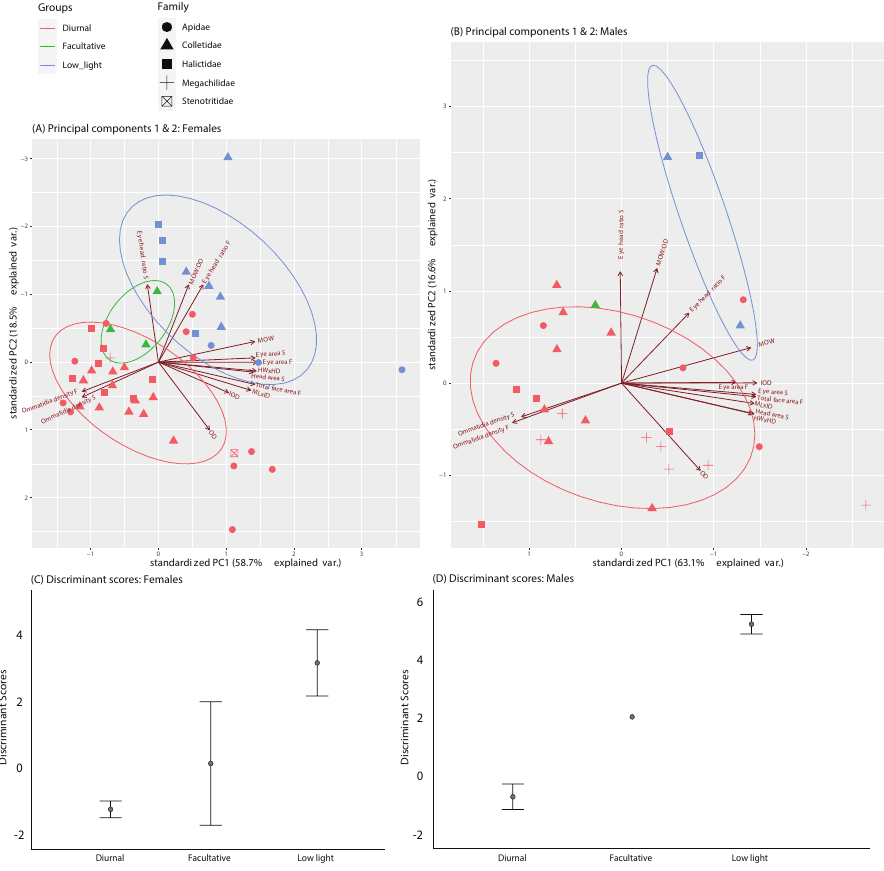
Figure 4. Principal components one and two of A female and B male bees where symbols indicate family (Apidae: circles, Colletidae: triangles, Halictidae: squares, Megachilidae: crosses and Stenotritidae crossed-squares) and colour indicates known foraging behaviour (diurnal: red, facultative low-light: green and obligate low-light: blue). Measurements are defined in Fig. 1. Plots A and B indicate relative factor loadings for the morphological traits as vectors from the centroid. Discriminant scores for both C female and D male analyses for each behavioural group showing means and 95% confidence